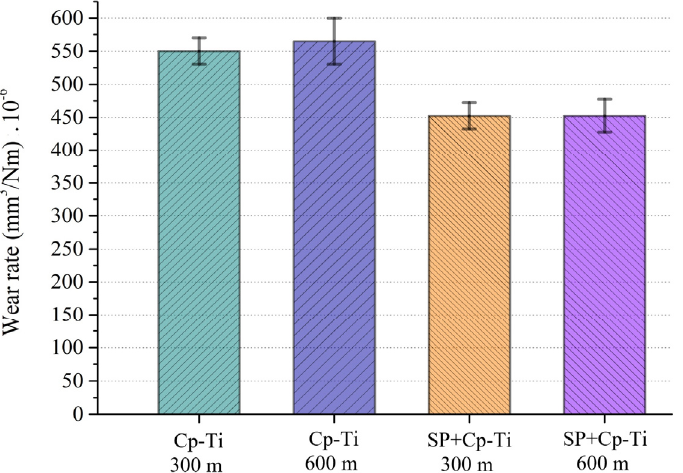
Figure 8. Specific wear rate of shot-peened (SP+Cp-Ti) and unpeened (Cp-Ti) at sliding distances of 300 m and 600 m.